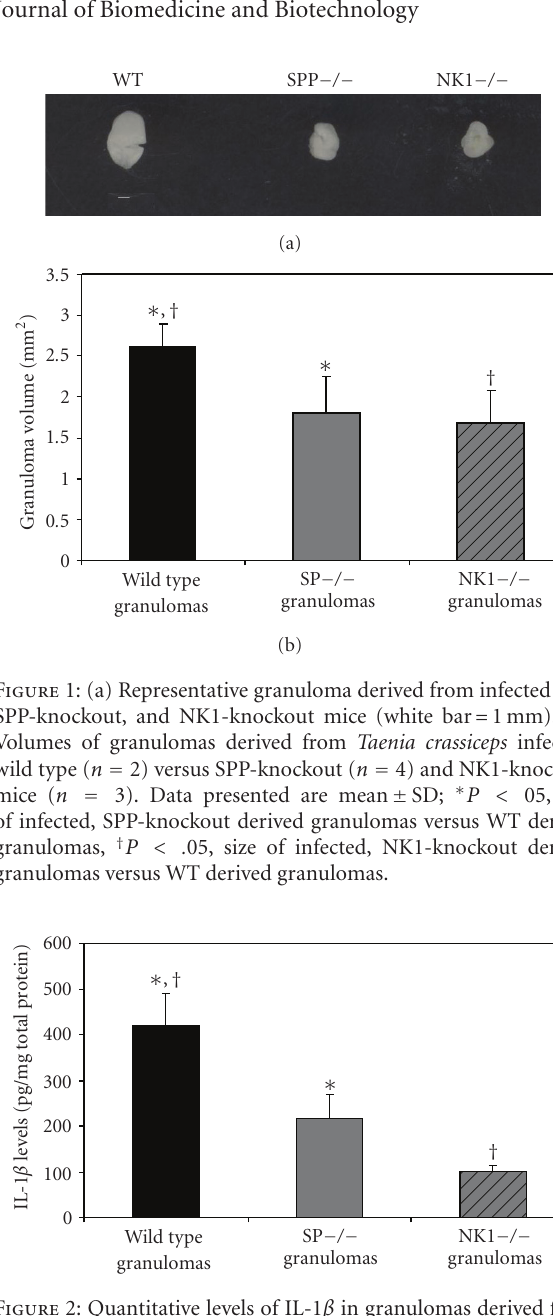
Figure 2: Quantitative levels of IL-1 β in granulomas derived from Taenia crassiceps infected, WT ( n = 15), SPP-knockout mice ( n = 6) and NK1-knockout mice ( n = 9). Data presented are mean ± SEM; ∗ P < 05, IL-1 β levels in infected, SPP-knockout derived granulomas versus WT derived granulomas; † P < . 05, IL-1 β levels in infected, NK1-knockout derived granulomas versus WT derived granulomas.